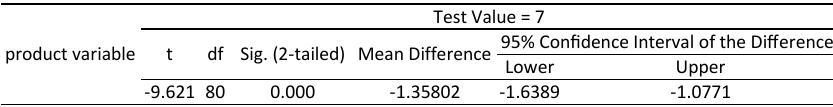
Table 5: One-sample t-test of product variable